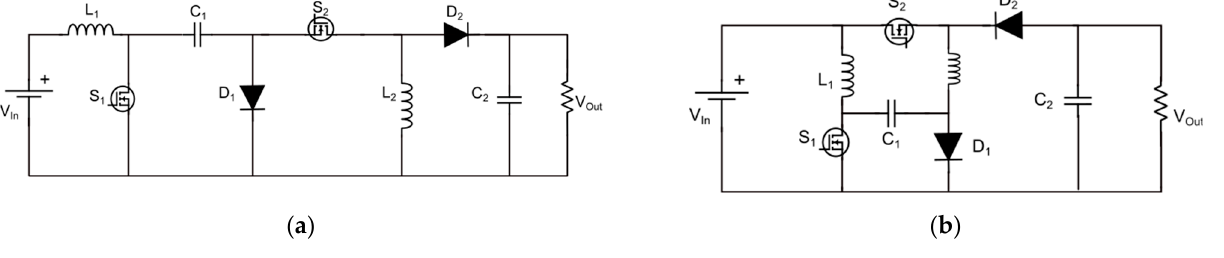
Figure 9. Transformer-less semi-quadratic buck-boost converter (SQBuBoC) ( a ). Semi-quadratic negative output buck-boost converter (NOBB) ( b ).